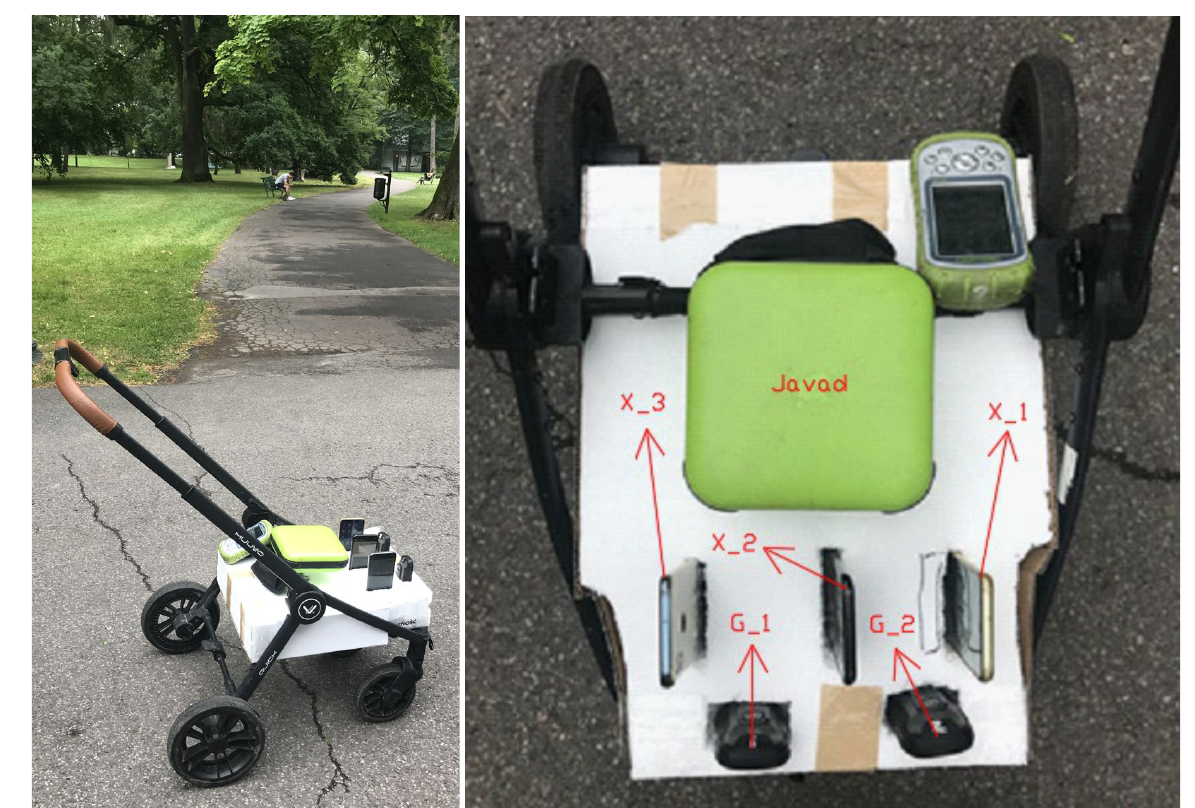
Figure 3. Survey equipment design and GNSS devices used in the study.